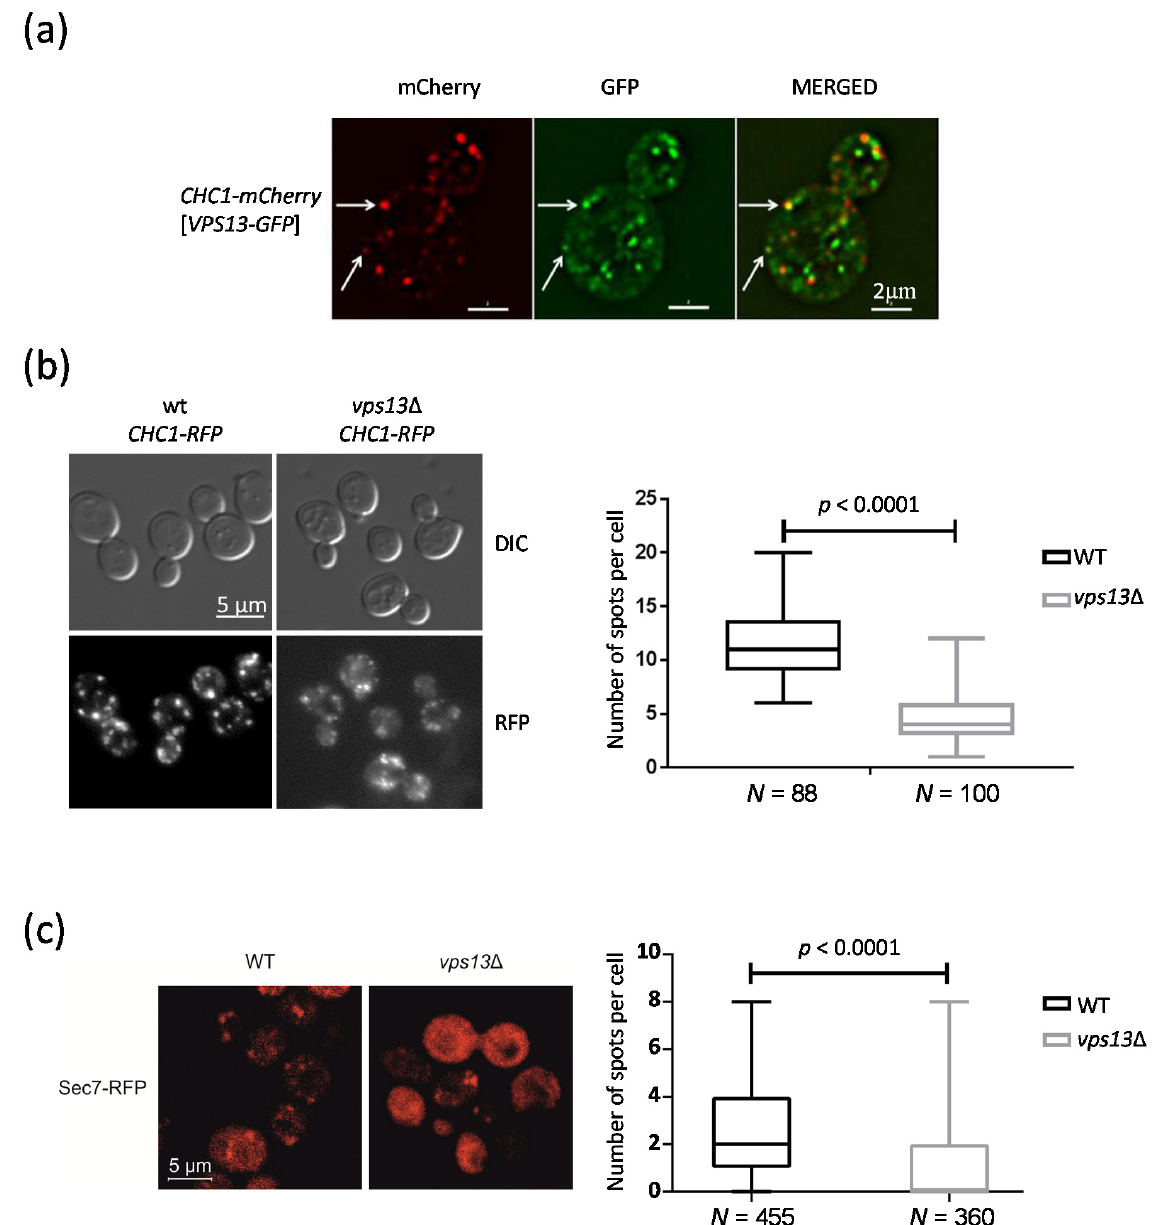
Figure 1. Vps13 co-localizes with Chc1 and the deletion of VPS13 affects the number of clathrin and Sec7 spots. ( a ) Vps13 co-localizes with Chc1. Fluorescence microscopy images showing the localization of Chc1-mCherry and Vps13-GFP. The arrows indicate spots corresponding to both Vps13-GFP and Chc1-mCherry. ( b ) The vps13 ∆ mutant cells have a reduced number of Chc1-RFP spots compared to wild-type (WT) cells. WT cells or the vps13 ∆ cells expressing CHC1-RFP were observed by fluorescence microscopy and by differential interference contrast (DIC) microscopy. The chart illustrates the number of Chc1-RFP spots per cell in WT and vps13 ∆ mutant cells from three independent cultures. Test- T : p < 0.0001; ( c ) Sec7-RFP localization is altered in the vps13 ∆ mutant cells. WT and vps13 ∆ mutant strains were transformed with a plasmid encoding the Sec7-RFP fusion protein. The localization of Sec7-RFP was observed by fluorescence microscopy. The number of visible spots per cell was counted in three independent experiments. Test- T : p < 0.0001.